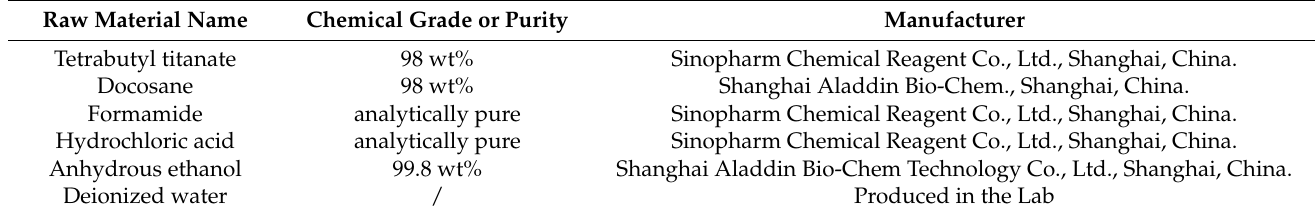
Table 1. List of experimental chemicals.